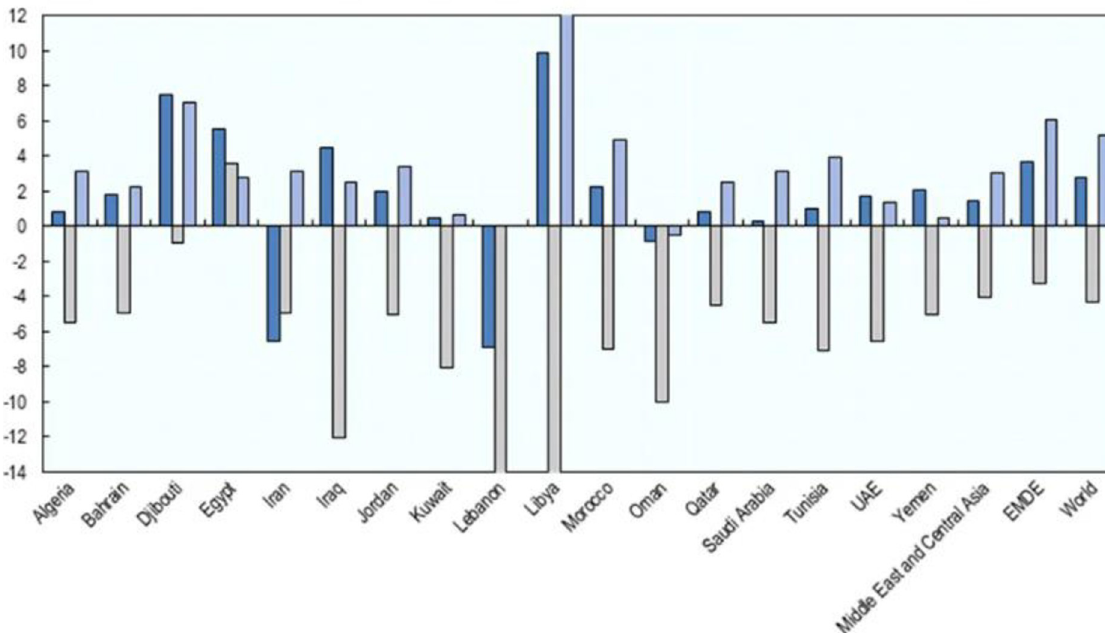
Fig 1. GDP in some MENA countries (year on year percent change). Source: IMF, World Economic Outlook Database, OECD [8]. Note: 2019—Dark blue, 2020—Grey, 2021—Light blue.